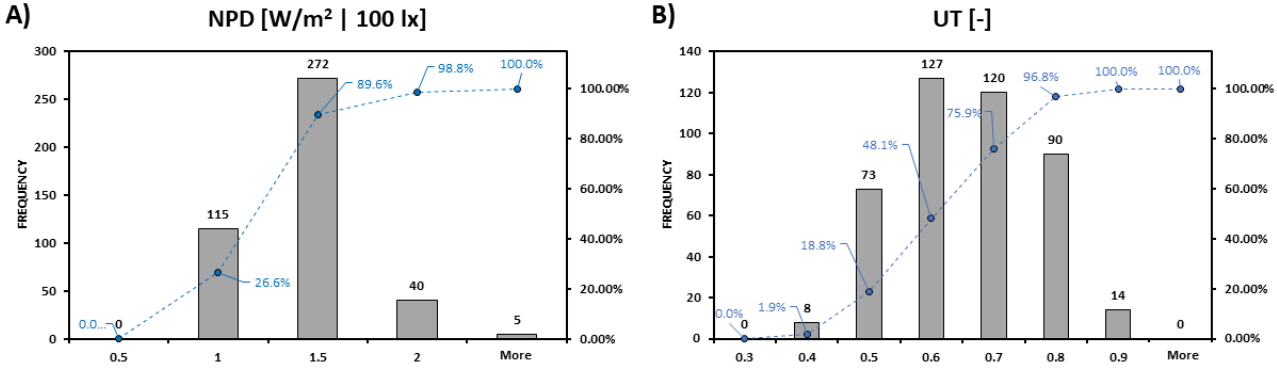
Figure 7. The histograms presenting the distribution of obtained results for: ( A )—Normalized Power Density and ( B )—Utilance.